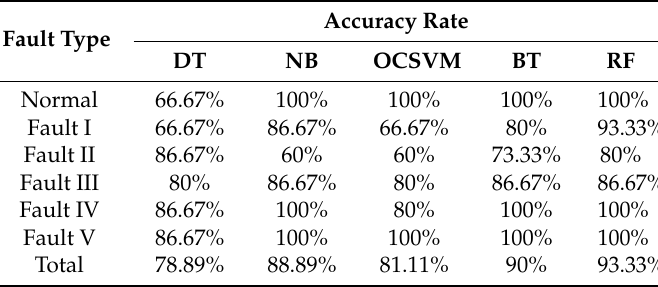
Table 4. WTFER-based diagnosis